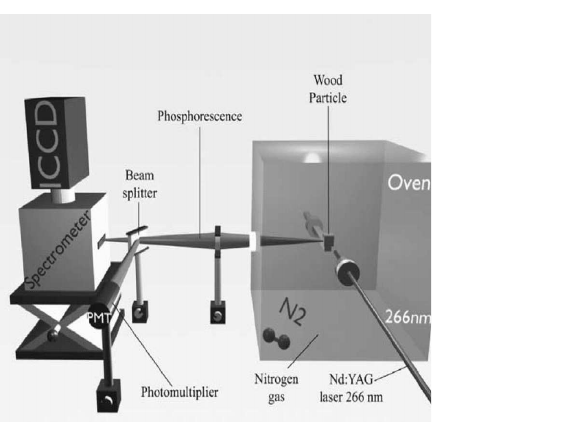
Figure 51. Schematic and results from the pyrolysis study for birchwood